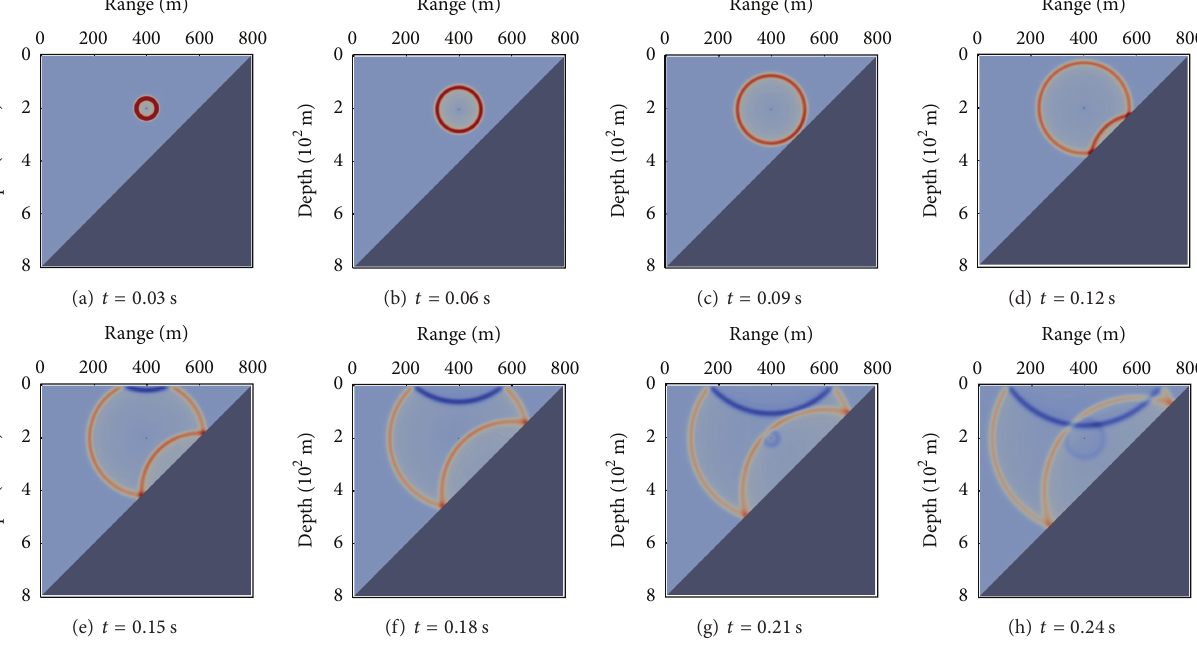
Figure 7: The simulation for the single pulse source problem in the ideal wedge geometry. The bottom boundary is set rigid. The t value of each snapshot is listed in the subtitles of the figures. The small blue rings around the source in (g) and (h) are the secondary reflections on the edge of the